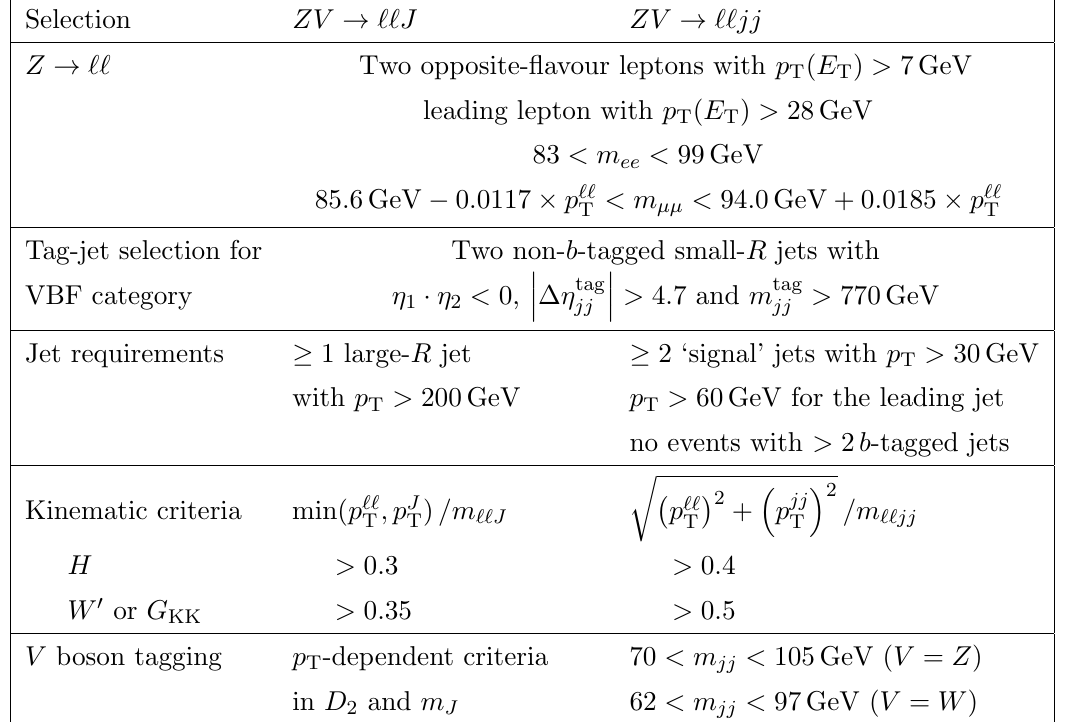
ZV ‘‘qq selection ! !